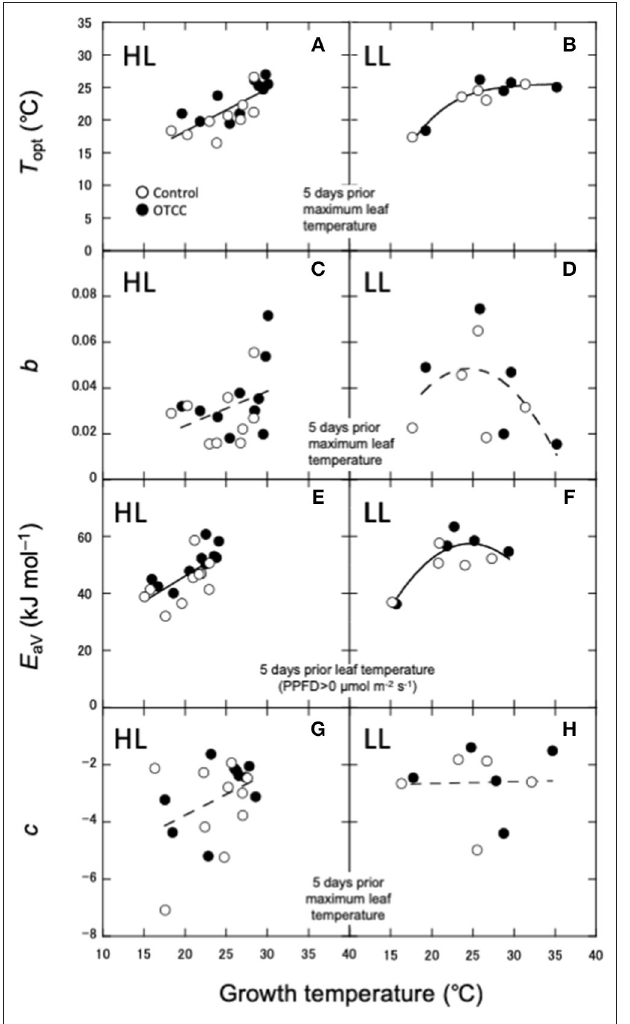
FIGURE 4 | Relationships between photosynthetic characteristics and growth temperature (GT). (A,B) Optimal temperature that maximizes photosynthetic rate ( T opt ); (C,D) spread of temperature response parabola ( b ); (E,F) activation energy of apparent V cmax ( E aV ); (G,H) temperature dependence of C i ( c ). HL, high latitude; LL, low latitude. The best GT for each parameter is selected based on the r 2 value for the correlations in HL (A,C,E,G) . The same GT is used as a predictor for respective parameter in LL (B,D,F,H) . For LL, Linear, polynomial and logistic equations are tested and the equation with the lowest AIC is selected. (A,E) are redrawn from Yamaguchi et al. (2016) with modifications.